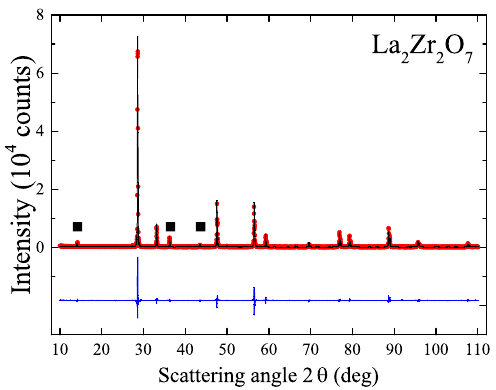
Figure 6. Room temperature powder X-ray diffraction pattern of a ground La 2 Zr 2 O 7 crystal grown in air at a growth rate of 15 mm/h. The experimental profile (red closed circles) and a full profile matching refinement (black solid line) made using the Fd ¯3 m cubic structure are shown, with the difference given by the blue solid line. ” (cid:110) ” indicate the low angle superlattice reflections of the pyrochlore